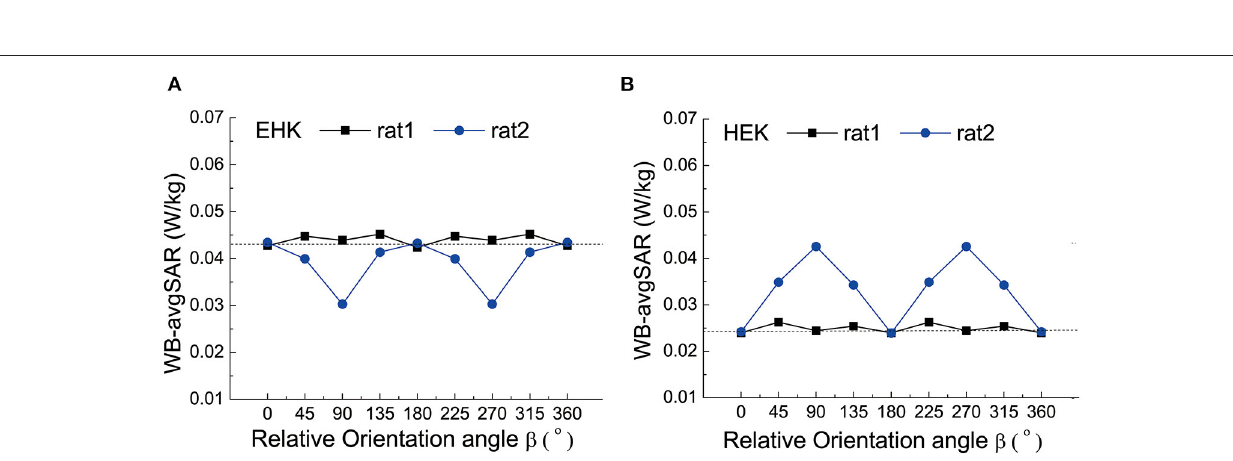
FIGURE 5 | The WB-avgSAR of two rats in different relative orientation angles β . (A) the simulation results of rat 1 laid flatly and in EHK radiation mode; (B) The simulation results of rat 1 laid flatly and in HEK radiation mode.